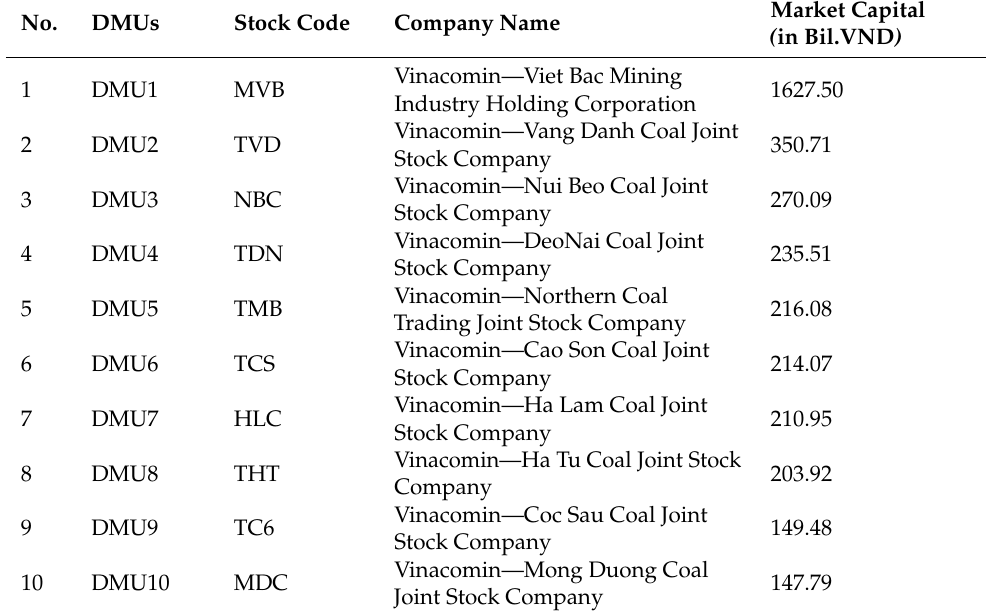
Table 2. The list of